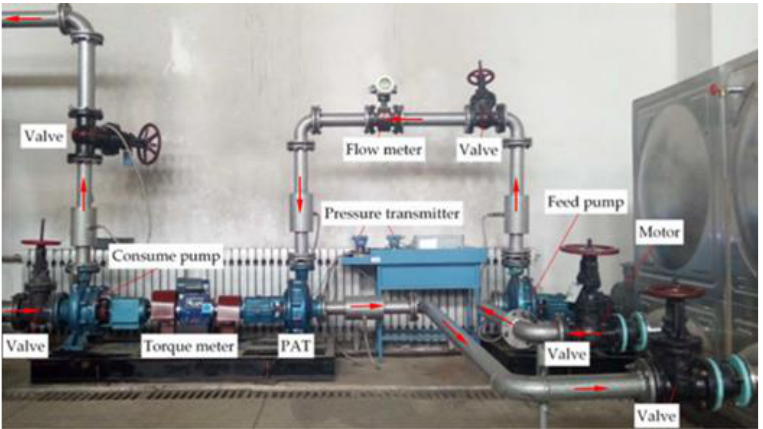
Figure 4. Test device for PAT characteristics.